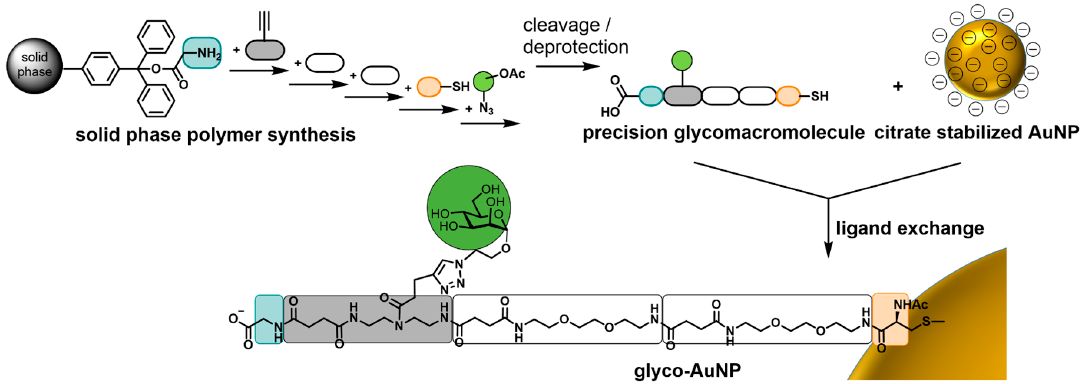
Scheme 1. Schematic representation of the combination of solid phase polymer synthesis and nanoparticle functionalization by ligand exchange